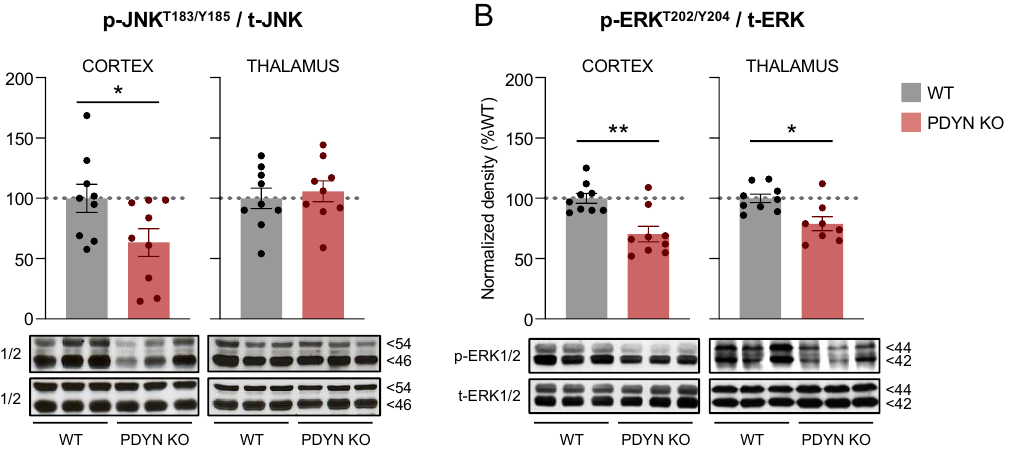
Figure 1. Immunodensities of activated ( A ) JNK1/2 and ( B ) ERK1/2 in cortical and thalamic brain tissue samples from WT (grey bars; n = 9) and PDYN-KO (reddish bars; n = 9) mice. Normalized enzyme activation was estimated as the ratio between phosphorylated (i.e., p-Thr183/Tyr185 JNK1/2 or p-Thr202/Tyr204 ERK1/2) to non-phosphorylated protein species. Columns are means ± SEM of each experimental group and expressed in percent change from WT animals for each brain region. * p < 0.05, and ** p < 0.01, Student’s t test. ( A , B ) Representative immunoblots of cortical and thalamic JNK and ERK phosphorylated and non-phosphorylated species (three different animals per group) are shown at the bottom. The indicated molecular weights (in kDaltons, kD) of the immunoreactive bands were estimated from in-gel-loaded, prestained protein standards.